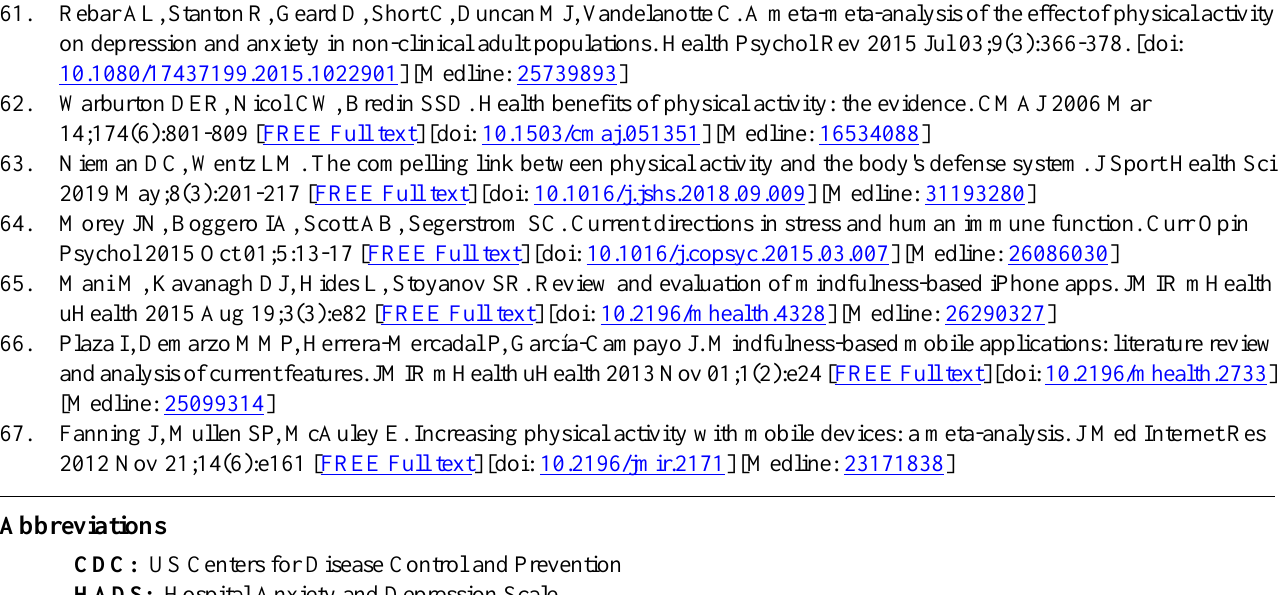
CDC: US Centers for Disease Control and Prevention HADS: Hospital Anxiety and Depression Scale